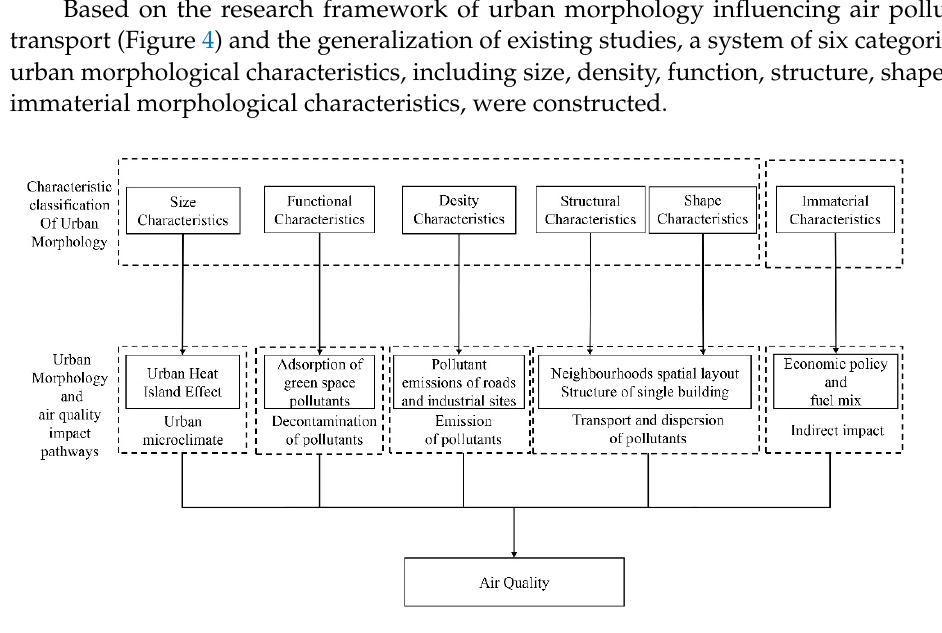
Figure 4. Framework of interaction mechanism between urban morphology and air quality.